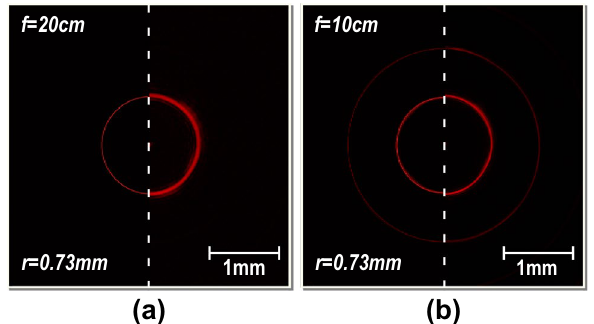
Figure 8. PVBs projected onto the camera CMOS sensor compared with the corresponding simulated results (superposed in the left part), generated by adding a lens to the DSA output at a distance z = 4 cm, with a focal distance f depending on the topological charge. ( a ) l = 4, f = 20 cm. ( b ) l = 8, f = 10